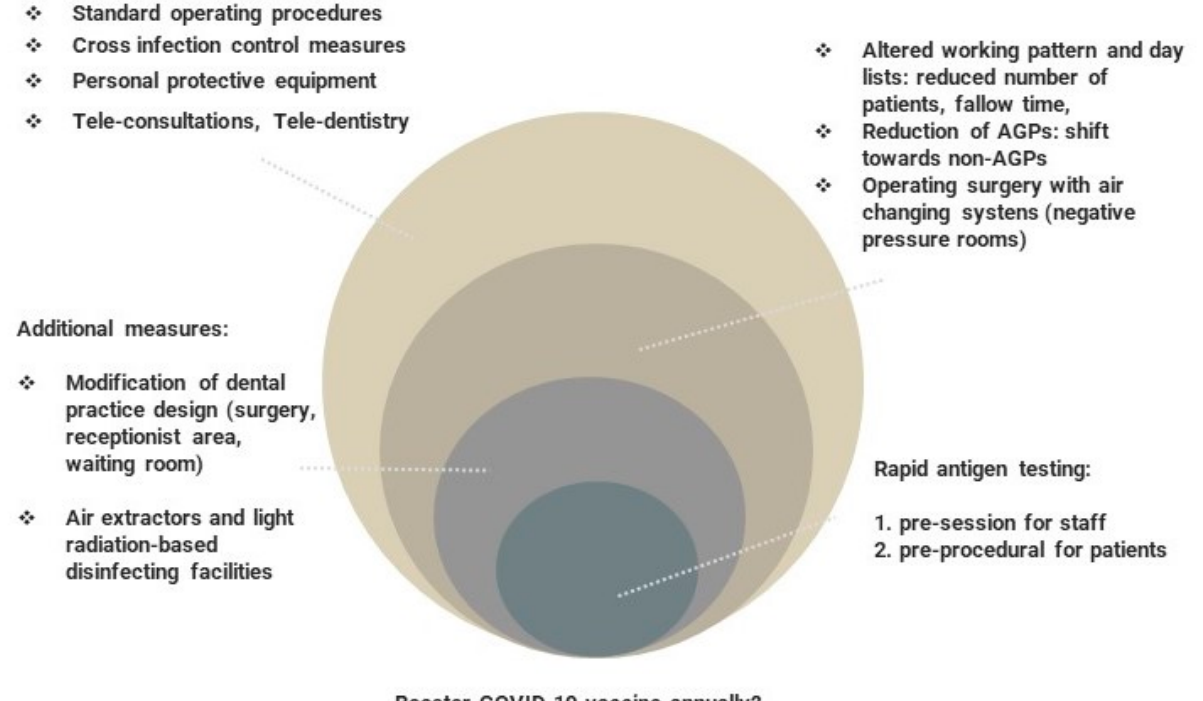
Figure 6. Prioritization of mitigation measures in dental care. The staged reinstallation of dental practice during and after the COVID-19 pandemic.